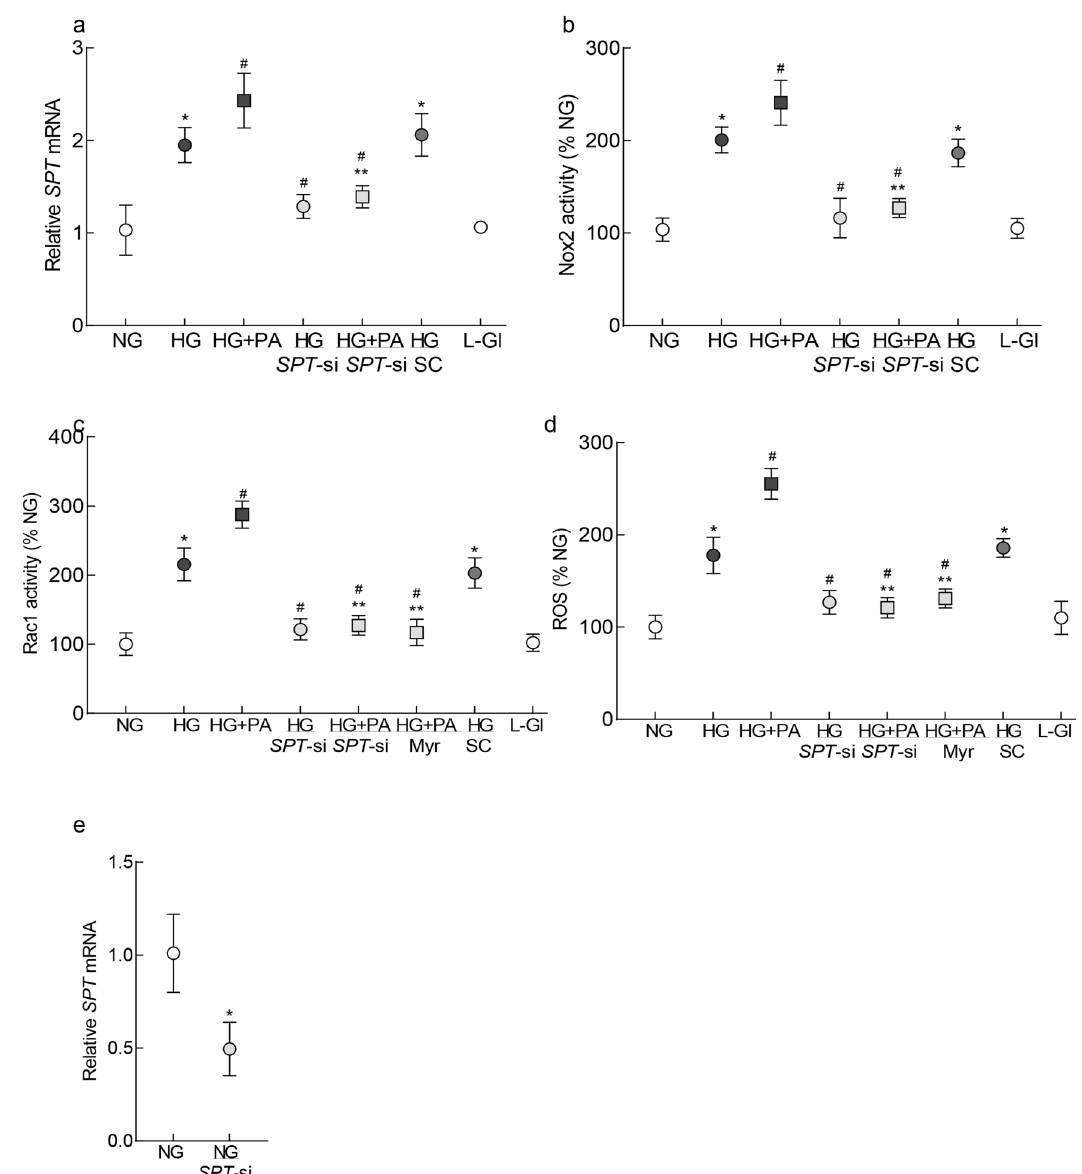
Figure 1. Inhibition of SPT and Rac1–Nox2–ROS signaling in HRECs. ( a ) SPT mRNA was quantified by qRT-PCR using β-actin as a house keeping gene. ( b ) Nox2 by using lucigenin as an electron acceptor and NADPH as a substrate and ( c ) Rac1 activity was determined by G-LISA colorimetric assay kit. ( d ) ROS levels were quantified by a fluorescence method using DCHFDA. ( e ) Transfection efficiency of SPT -siRNA was determined by quantifying the relative mRNA of SPT . Each measurement was made in duplicate, and the values are represented as mean ± SD from 3–4 cell preparations. NG and HG = 5 mM or 20 mM d-glucose; HG + PA = 20 mM d-glucose + palmitic acid; HG/ SPT -si and HG + PA/ SPT -si = SPT -siRNA transfected cells in 20 mM d-glucose or 20 mM d-glucose + palmitic acid; HG + PA/Myr = 20 mM d-glucose + palmitic acid + Myriocin; HG/SC = SPT -scrambled control RNA transfected cells in 20 mM d-glucose; L-Gl = 20 mM l-glucose. *p < 0.05 vs NG, # p < 0.05 vs HG and # **p < 0.05 vs HG + ferent from their respective untransfected cells (p < 0.05). Scrambled control RNA transfected cells, incubated with high glucose, had similar values as those obtained from untransfected cells in high glucose. Cells in 20 mM l-glucose, instead of 20 mM d-glucose, had similar DNA methylation–hydroxymethylation status of Rac1 pro- moter similar to that observed in the cells incubated in 5 mM d-glucose. Diabetic mice. Establishment of type 1 and type 2 diabetic animal models. Glucose tolerance test, per- formed 2–3 days prior to the termination of the experiment, showed impaired glucose utilization even two hours after its infusion, with high glucose values in both streptozotocin-induced type I diabetic mice (Diab group) and